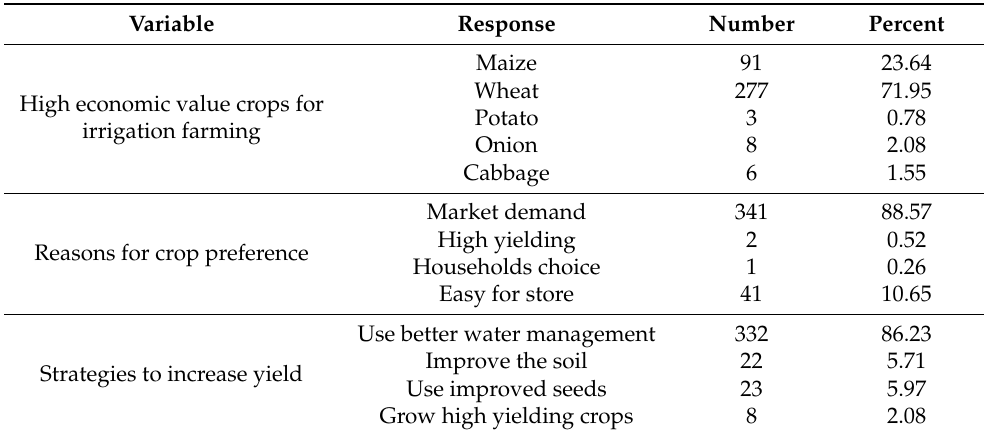
Table 7. Perceived irrigated crops and reasons for crop selection in Koga Irrigation